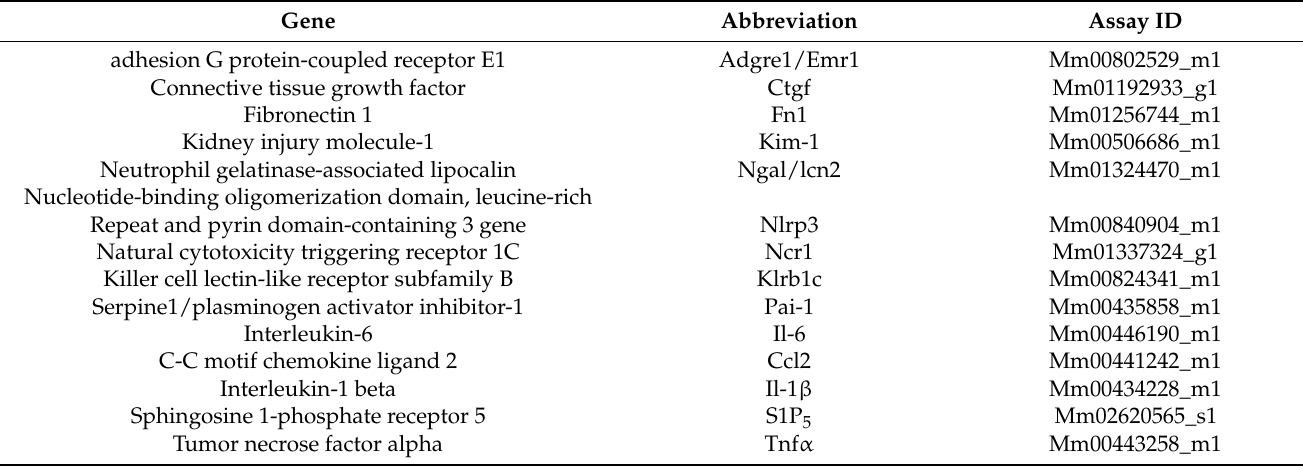
Table A1. Genes and Assay IDs used for TaqMan ®